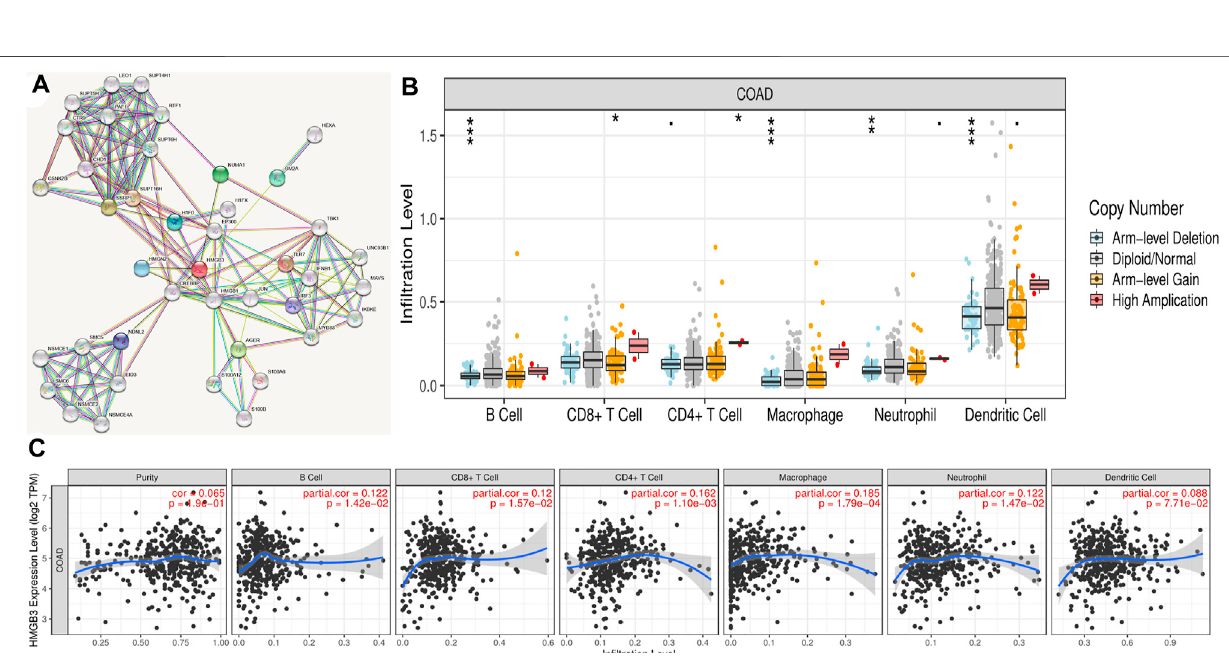
Frontiers in Cell and Developmental Biology |